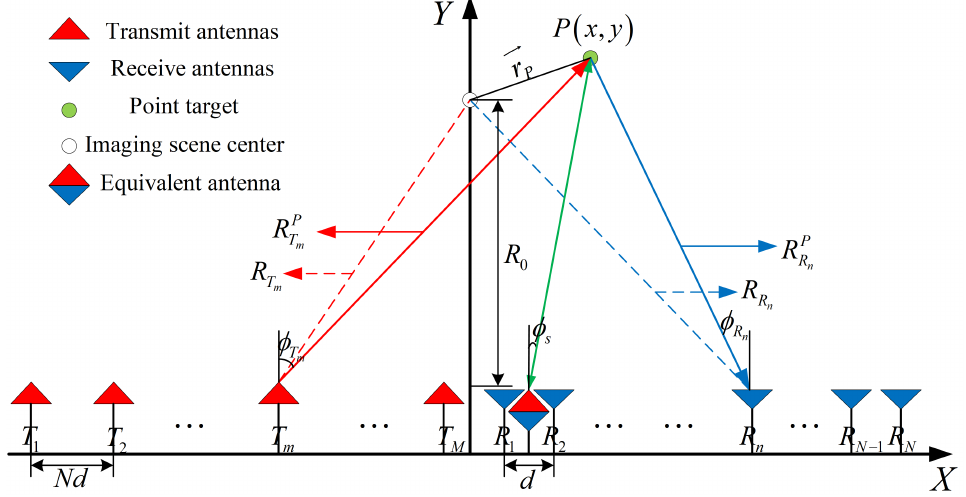
Figure 1. Forward-looking imaging structure model of MIMO